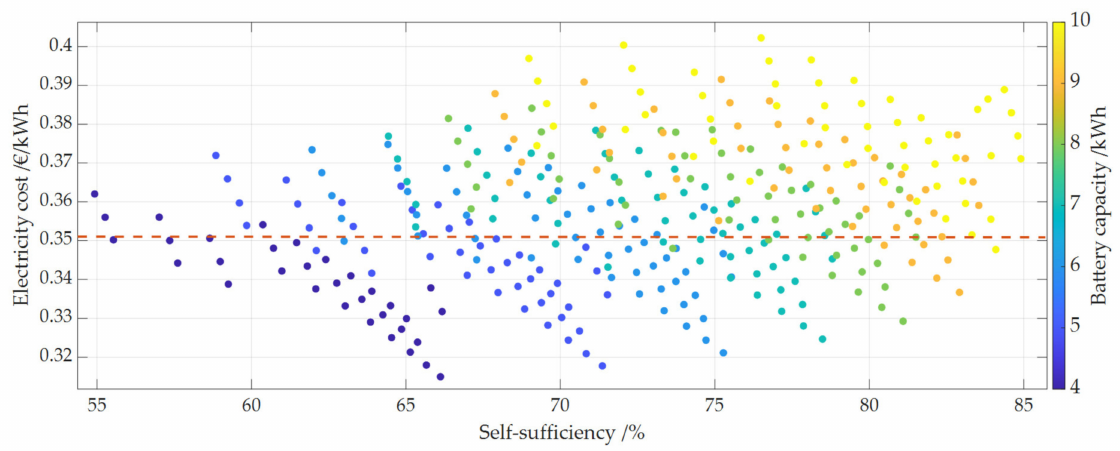
Figure 10. Electricity costs as a function of self-sufficiency, the capacity of the battery is shown in color. The simulation is based on an annual electricity price increase of 1%.